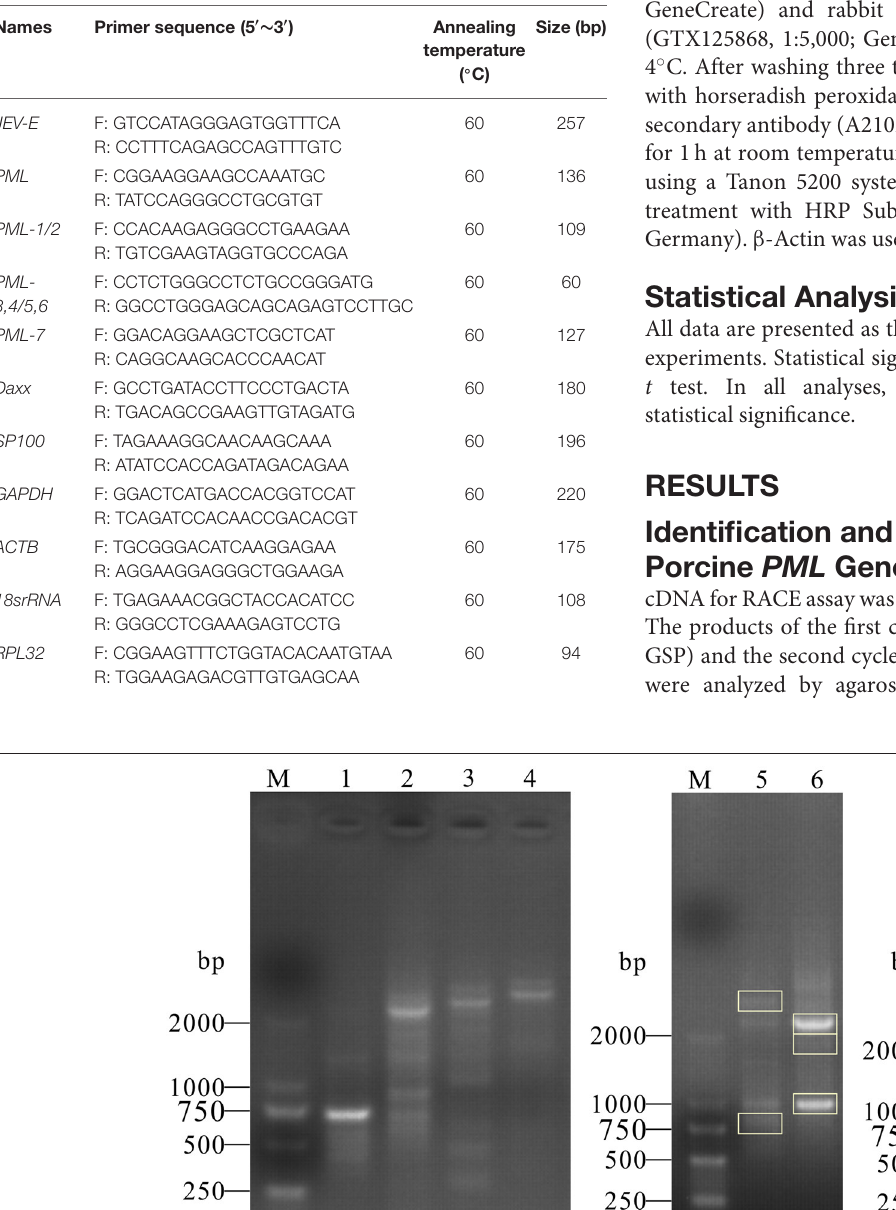
TABLE 3 | The sequences of RT-qPCR primers.